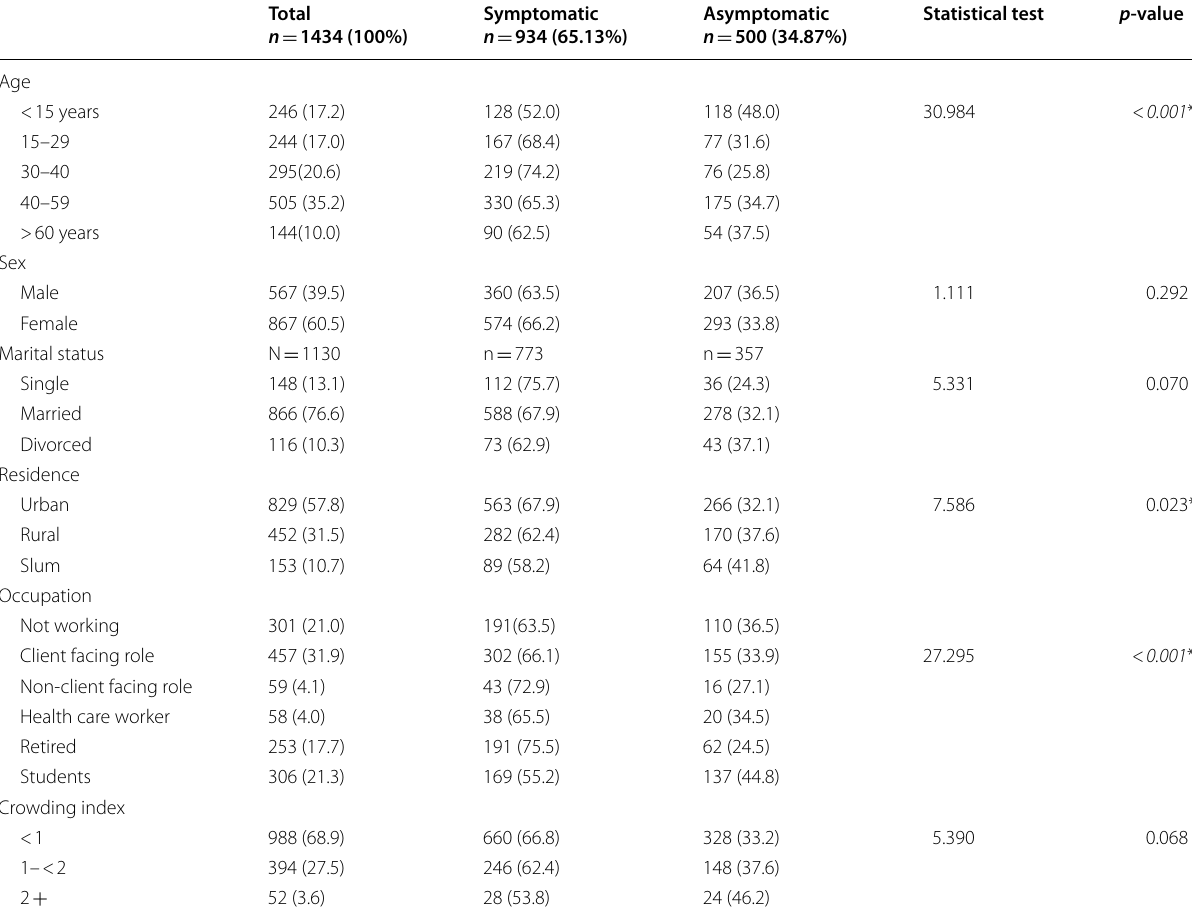
Table 1 Distribution of the symptomatic and asymptomatic participants to socio‑demographic